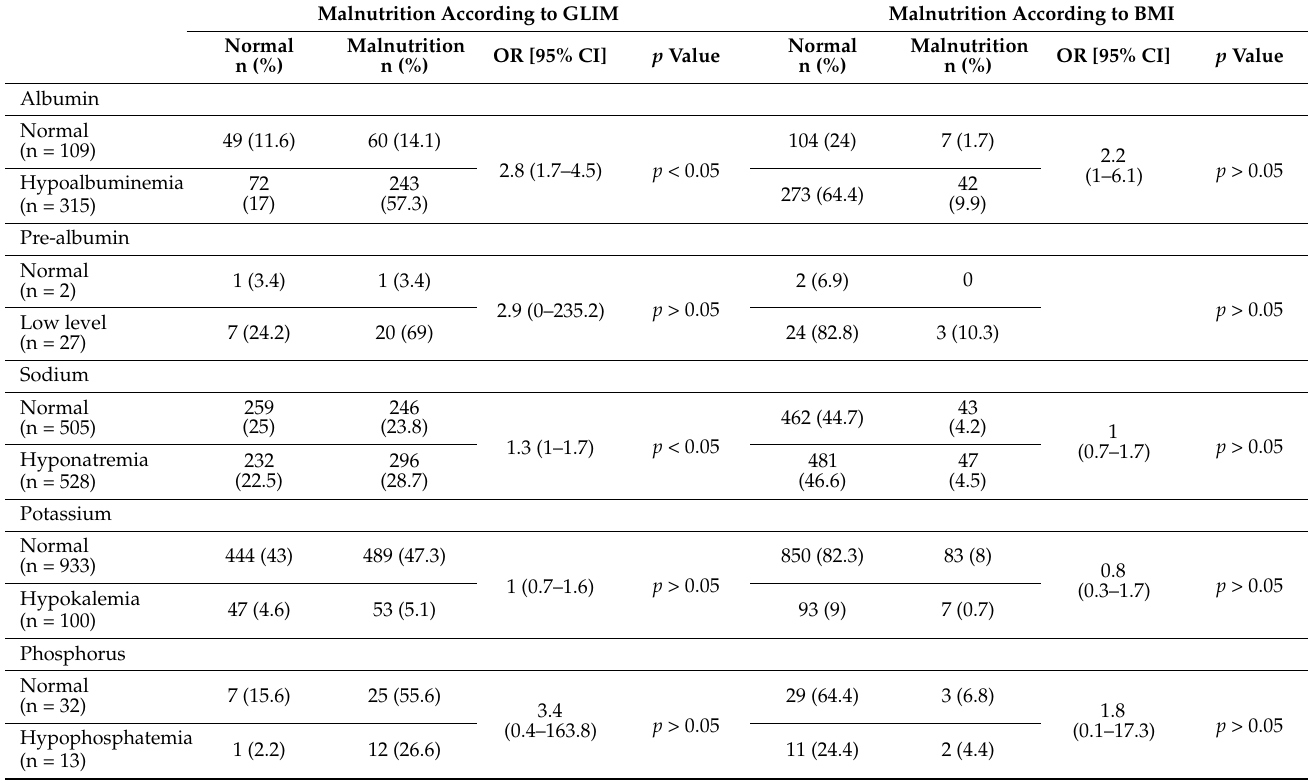
Table 4. Association between laboratory tests and malnutrition according to GLIM and BMI.